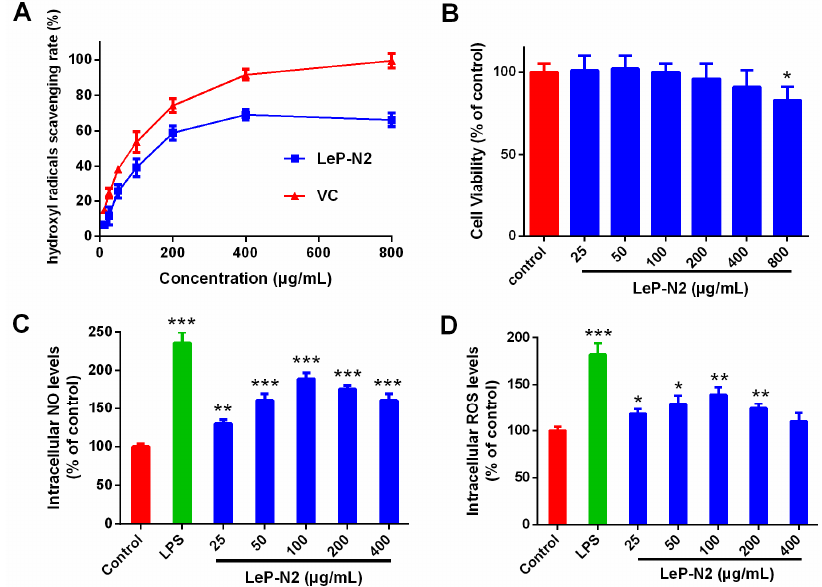
Figure 5. The bioactivities of LeP-N2: The e ff ects on ( A ) the Hydroxyl radical scavenging activity; ( B ) the cell viability; and the ( C ) nitric oxide (NO) and ( D ) reactive oxygen species (ROS) production. The data are means ± SD of triplicate experiments. Significant di ff erences between the groups were analyzed with a Students’ t test. * p < 0.05, ** p < 0.01, and *** p < 0.001 vs. the untreated group (medium).